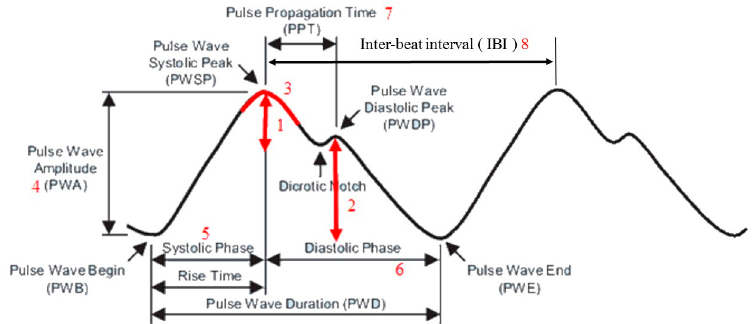
Figure 5. Time-domain features of the PPG signal.